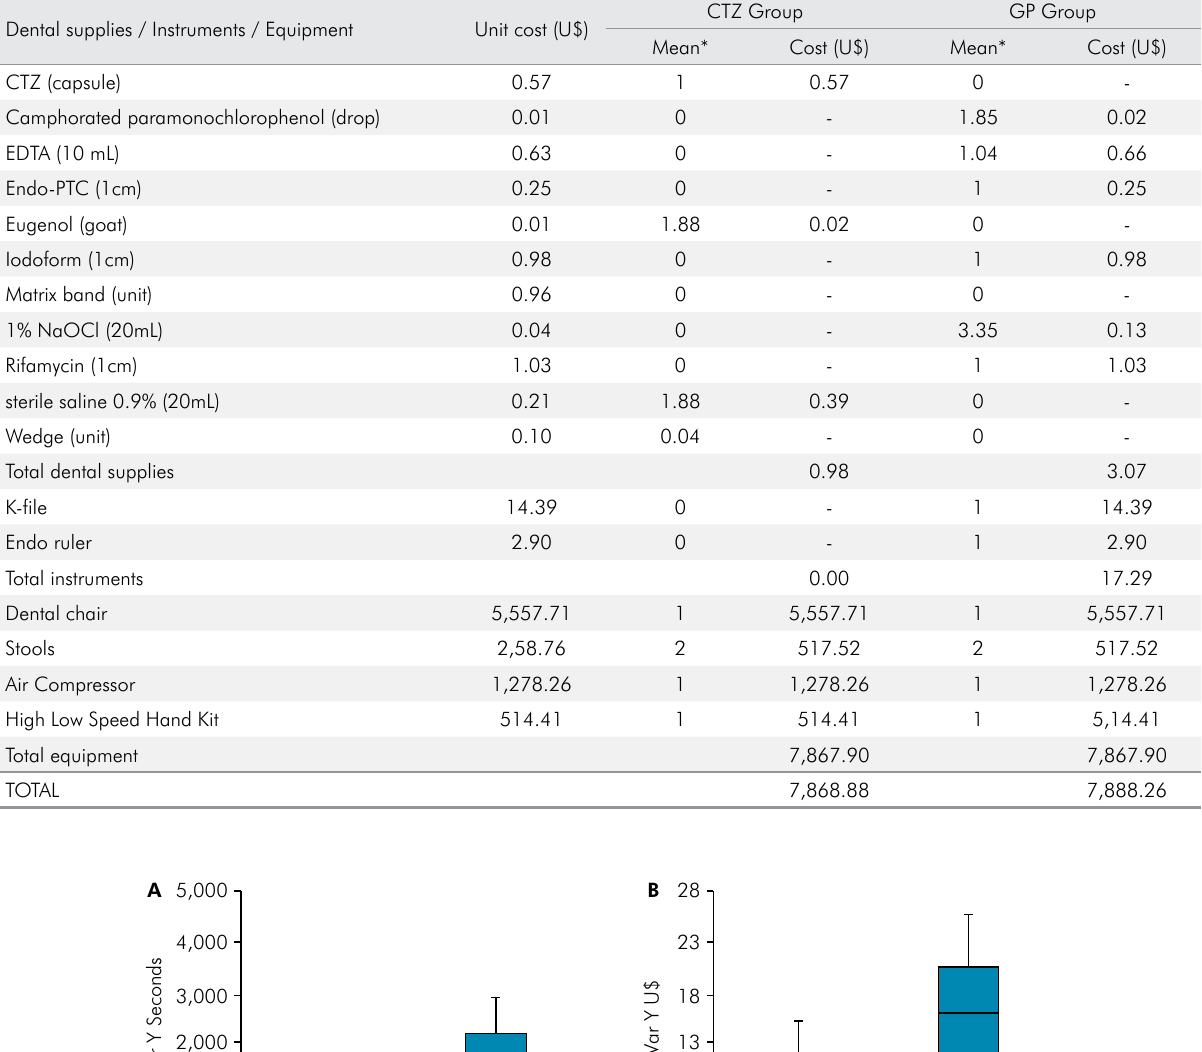
Table 4. Description of absolute values of dental supplies, instruments and equipment used in endodontic treatments performed in the CTZ and GP groups.